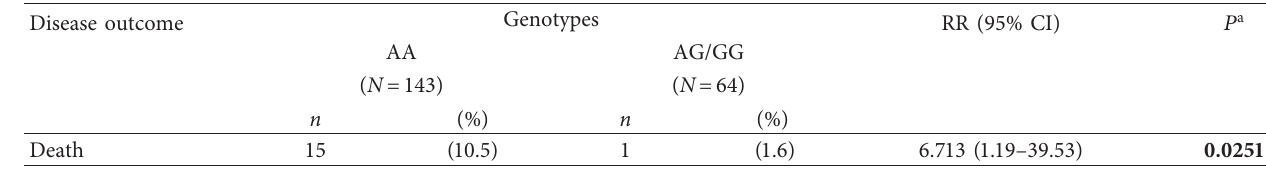
Table 2: Association of death/survival outcomes with rs562556 genotypes.